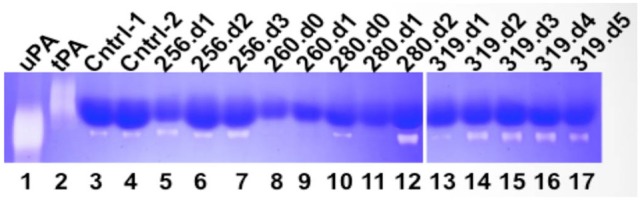
Qualitative zymography used to determine active tPA and uPA in plasma drawn from Class III HCPS cases (256, 260, 280, and 319). Coomassie blue stained zymogram reveals sites of proteolysis as white bands on a dark blue background. Data indicates active uPA in HCPS cases (note lanes 7, 12, 14, 15, 16, and 17). tPA activity was not detected. Although control samples indicate active uPA, the HCPS cases are notable, because of high levels of circulating PAI-1 in these subjects (Table 1).